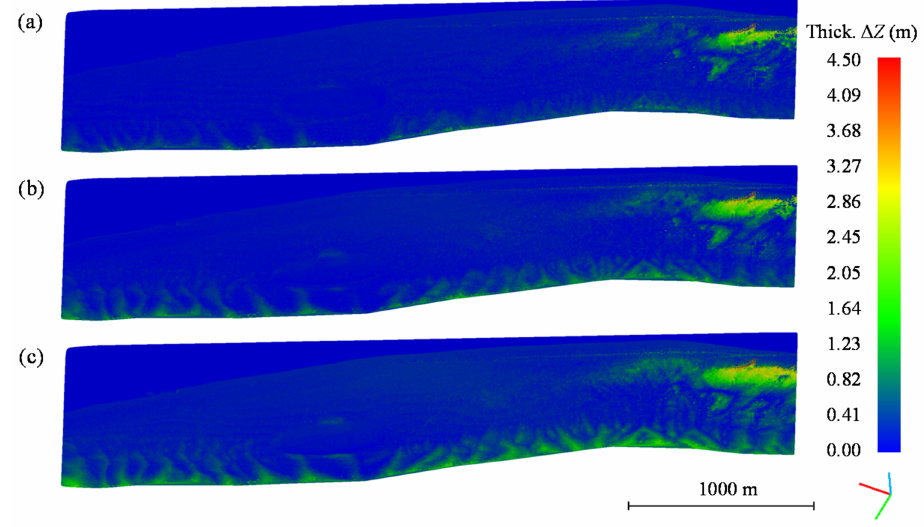
Figure 9. Distributions of deposition thickness after ( a ) 6, ( b ) 12, and ( c ) 18